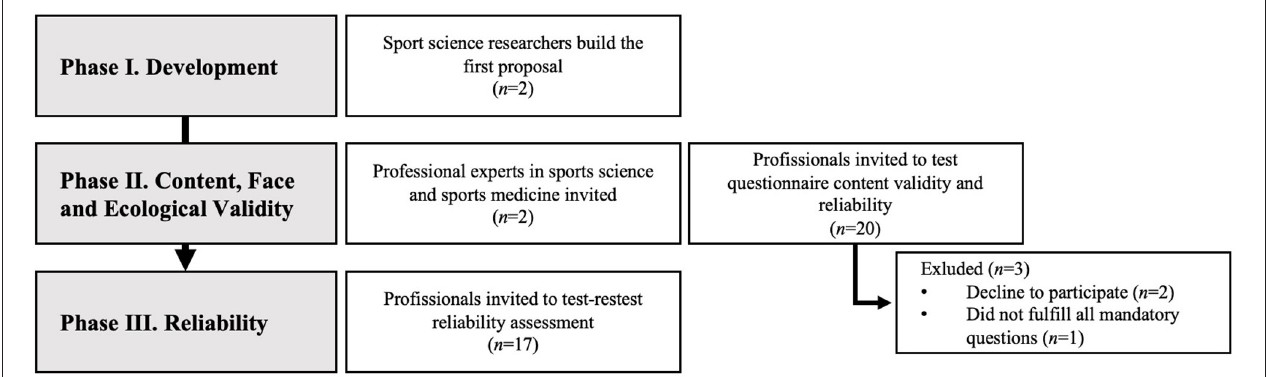
FIGURE 1 | Flow diagram of sample attendance and questionnaire validation